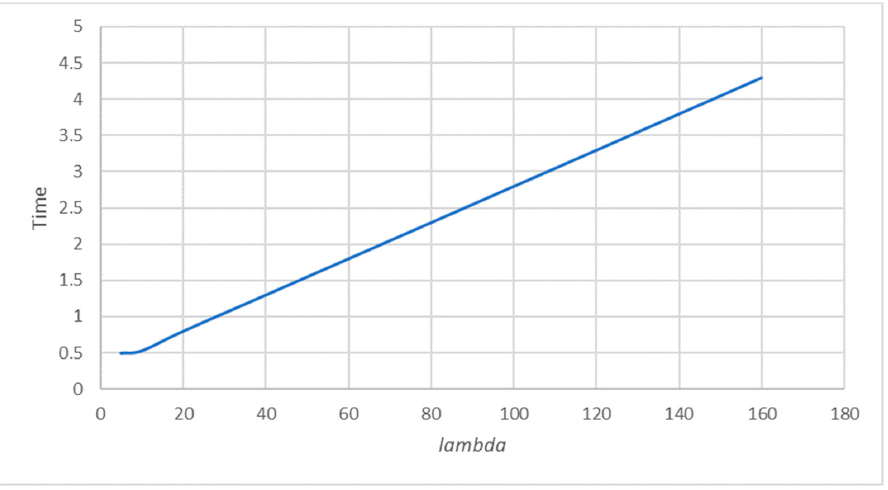
Figure 11. Average time of 10,000 iterations depending on the lambda parameter value.